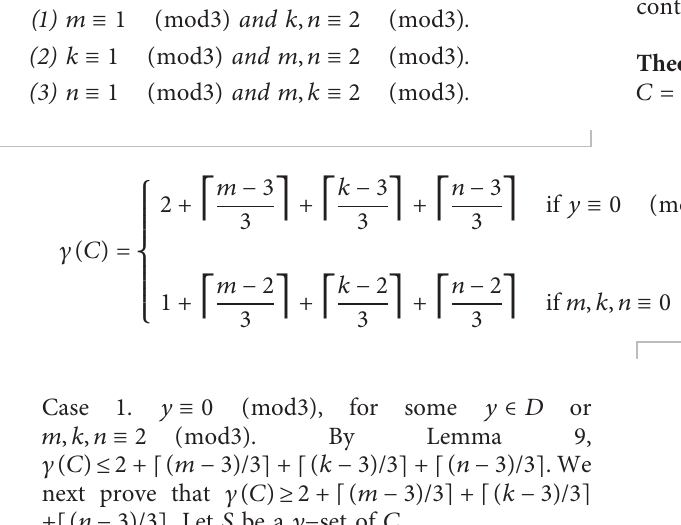
Figure 10: C ( m,k, n ) − N [ 2